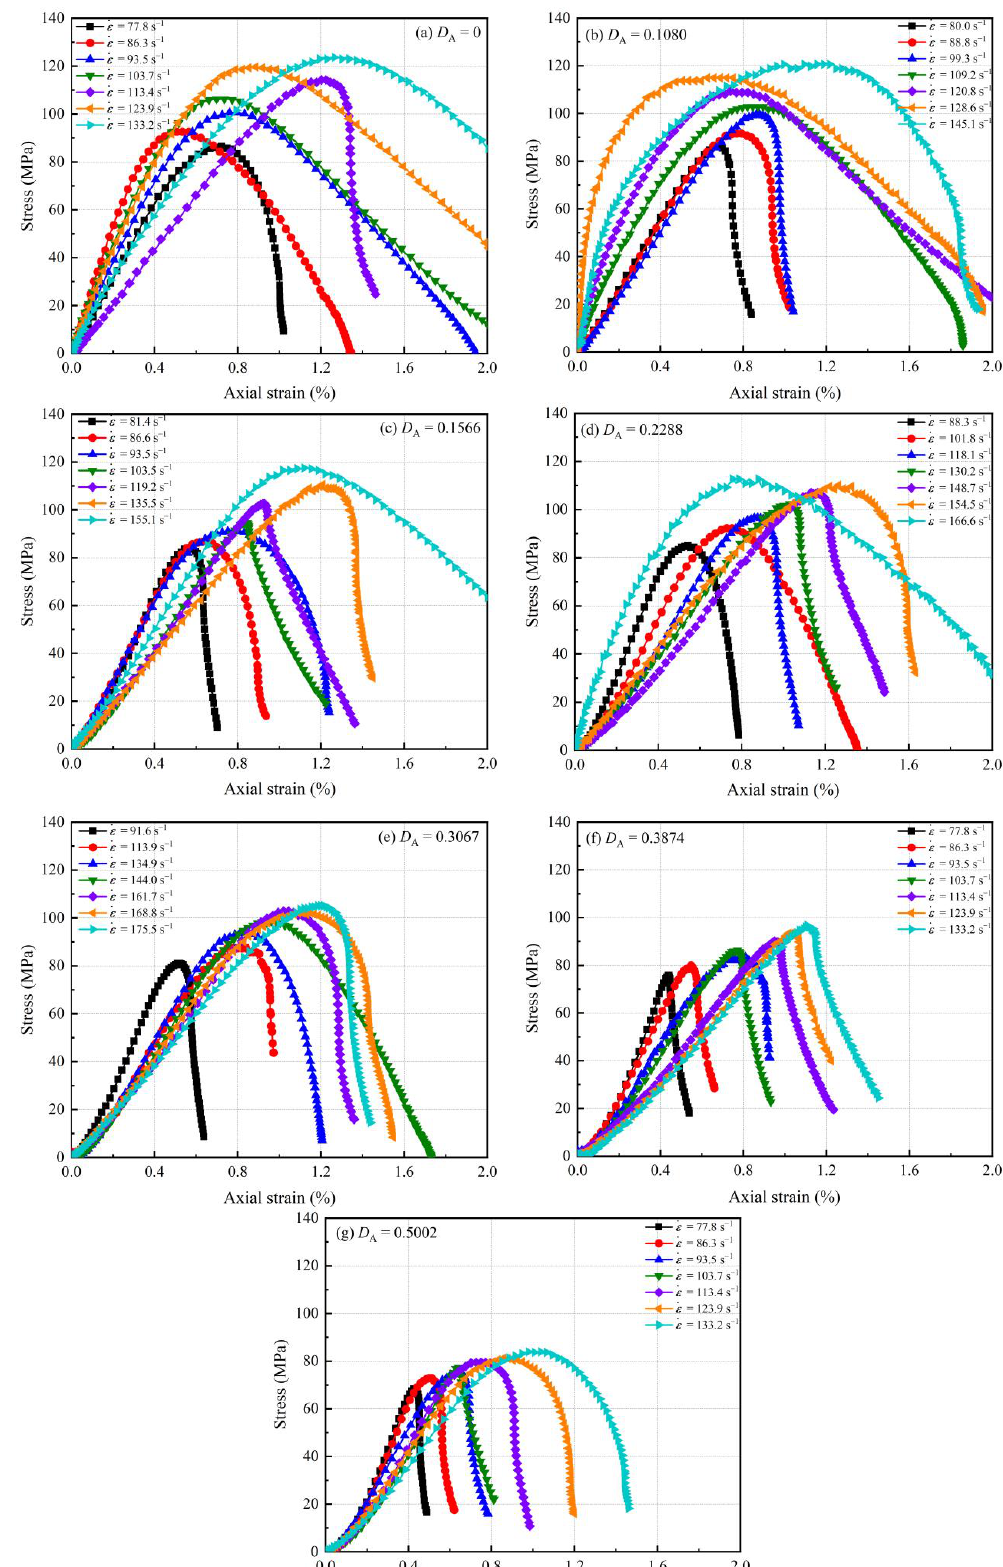
Figure 9. Dynamic stress-strain curves of sandstone: ( a ) D A = 0; ( b ) D A = 0.1080; ( c ) D A = 0.1566; ( d ) D A = 0.2288; ( e ) D A = 0.3067; ( f ) D A = 0.3874; ( g ) D A =